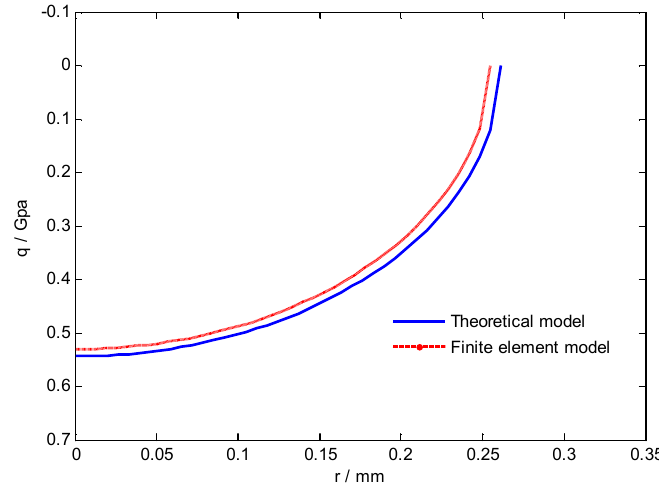
Figure 12. Normal stress on the circular thin plate vs. r.